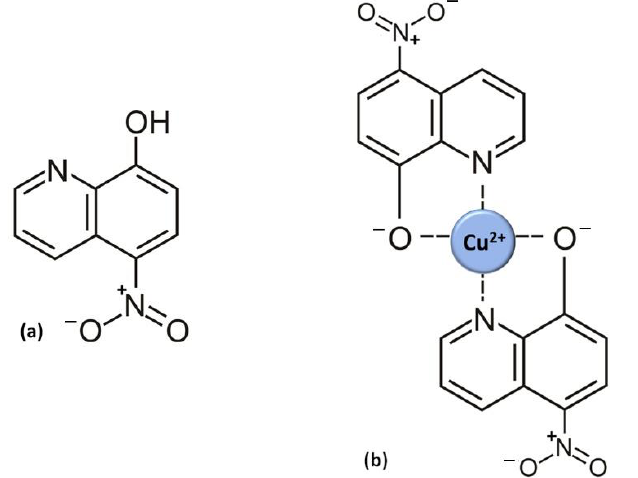
Figure 1. ( a ) Structure of nitroxoline (5-nitro-8-hydroxyquinoline, NIT); ( b ) example of NIT − Cu 2+ chelate, showing two possible chelating